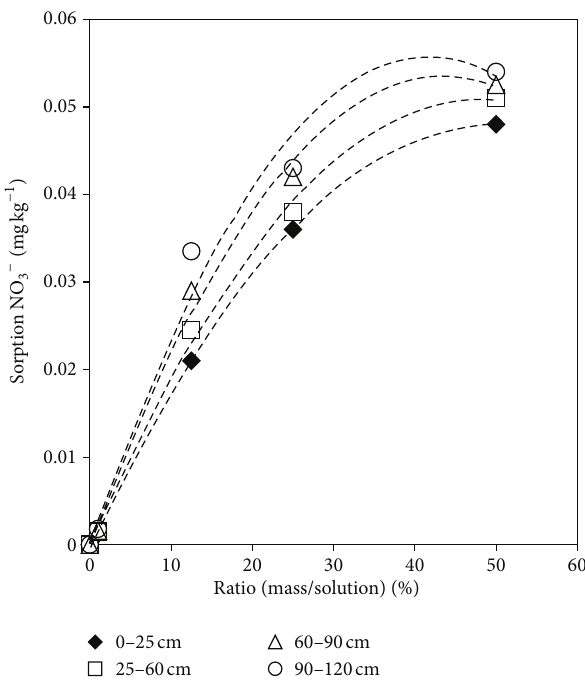
Figure 2: Effect of soil-solution ratios on NO 3− sorption for 4 soil depths from a batch experiment using an iso-humic soil from Chott Meriam, Tunisia (soil/solution ratios: 1%, 12.5%, 25%, and 50%, 22 ∘ C,